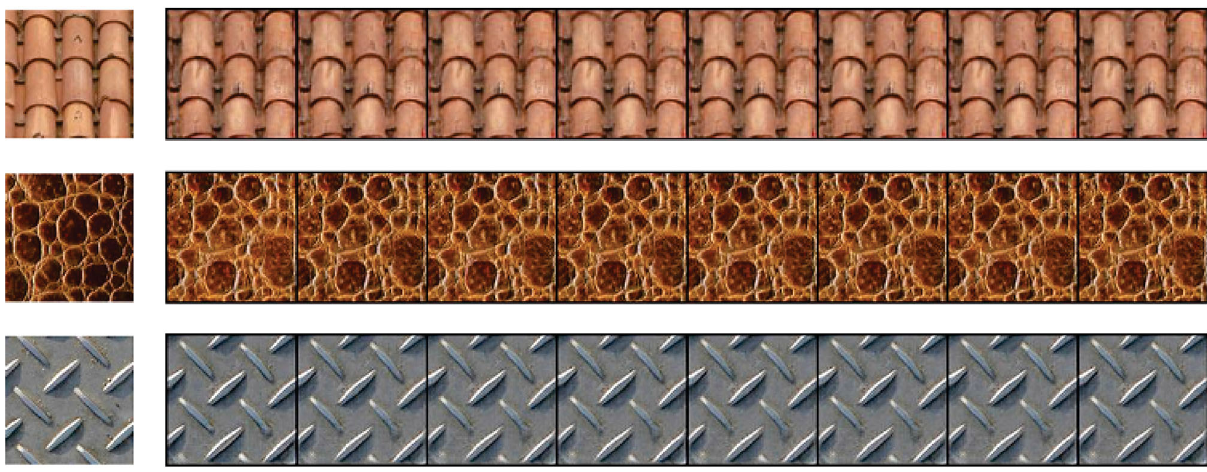
Fig. 6 Stability test. Textures were generated in a loop. In the first iteration, co-occurrences are taken from the test set. In the next, co-occurrence of the generated texture is used. The original crop from the texture exemplar is on the left and the generated sequence for eight iterations is on the right. It can be noted that the textures remain stable over the iterations.